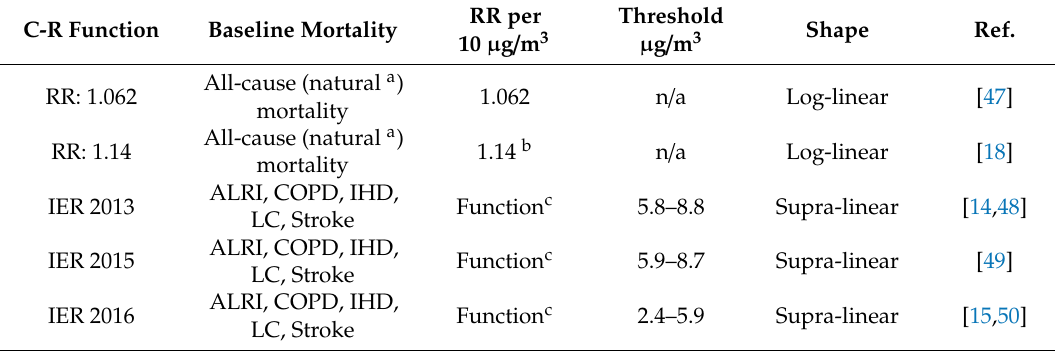
Table 4. Concentration-response (C-R) functions applied for PM 2.5 in the C-R